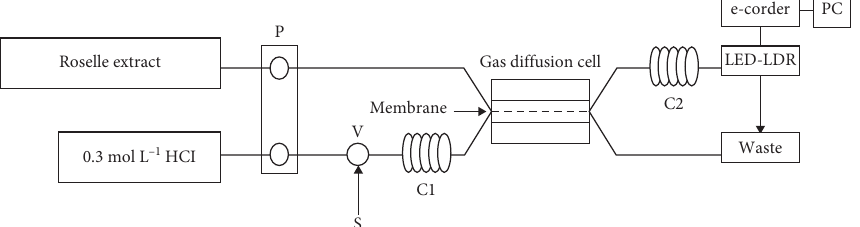
Figure 1: Manifold of FI-GD photometric flow system for determination of sulfite; P � peristatic pump, V � six-port valve, S � standard/ sample, C1 and C2 � mixing coils, and PC � personal